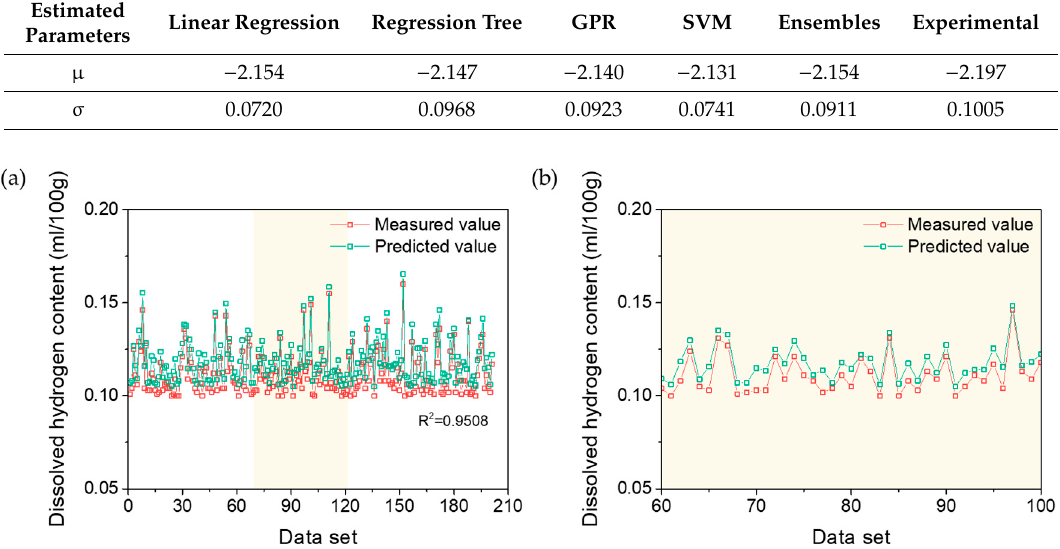
logarithmic values.